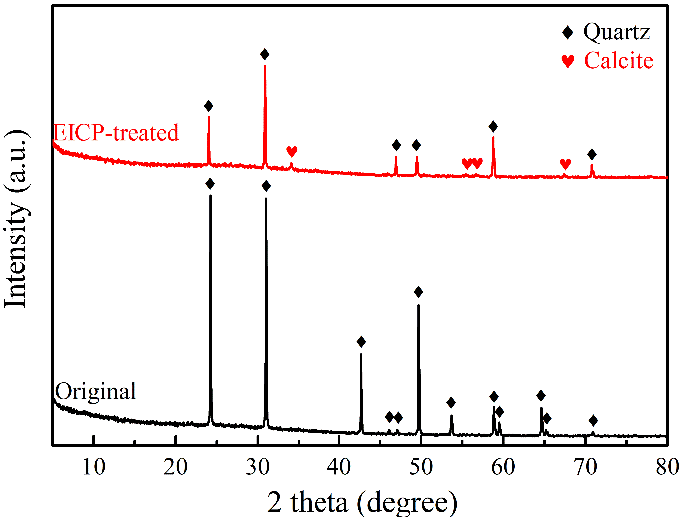
Figure 8. XRD analysis of untreated and EICP-treated (60 g/L powdered soybean) sand. Figure 9. XRD analysis of untreated and EICP-treated (60 g/L powdered soybean) sand.